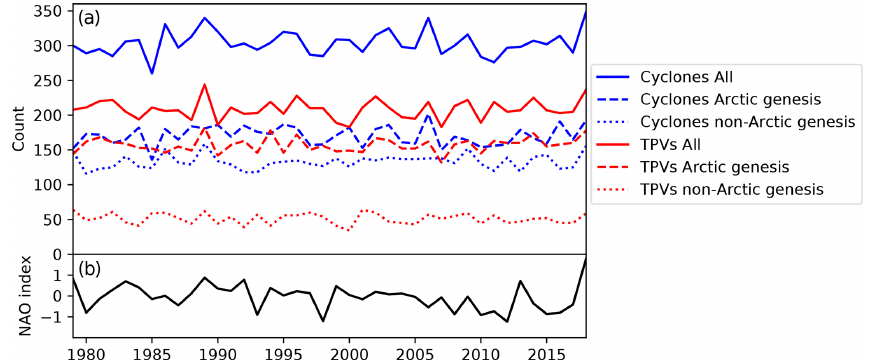
Figure 5. Time series of extended-summer counts of Arctic cyclones and TPVs with a lifetime of ≥ 1d (a) and the average extended-summer NAO index from 1979–2018 (b)